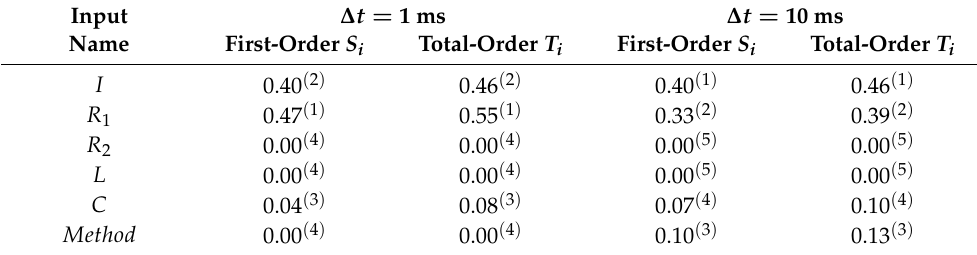
Table 7. First- and total-order Sobol indices at t = 10 ms considering the integration method as an additional input (with ∆ t = 1 ms and ∆ t = 10 ms). Analysis of this table provides the answer to Question